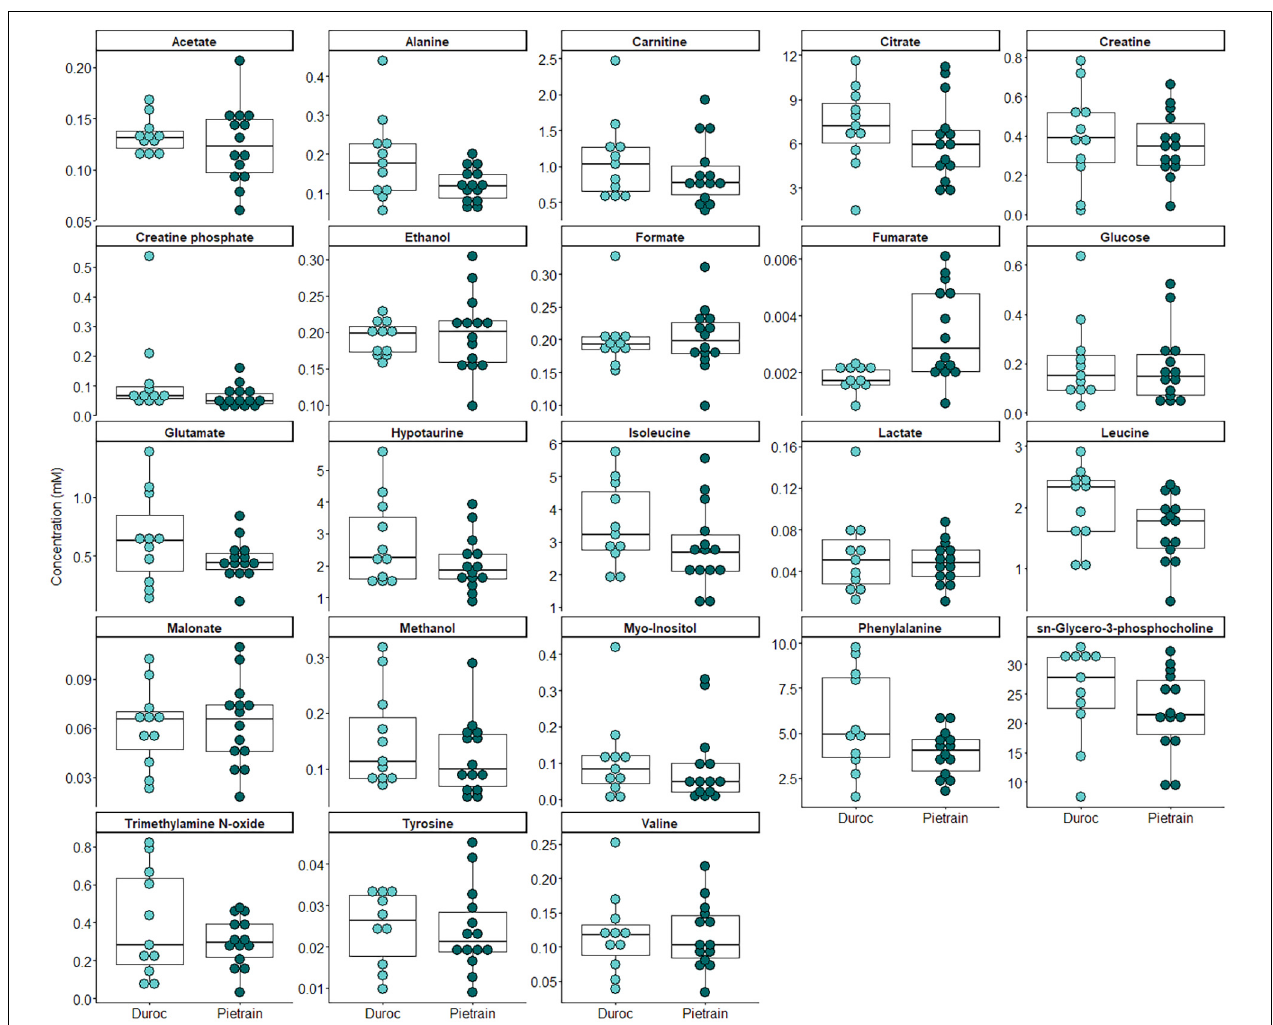
FIGURE 2 | Concentration of metabolites in seminal plasma from ejaculates (one per boar) of different pig breeds (Pietrain, n = 14 and Duroc, n = 11). Boxes enclose the 25th and 75th percentiles, the whiskers extend to the 5th and 95th percentiles, and the line indicates the median. Each dot represents the metabolite concentration from each ejaculate. Differences between breeds ( P < 0.05) are represented as ∗